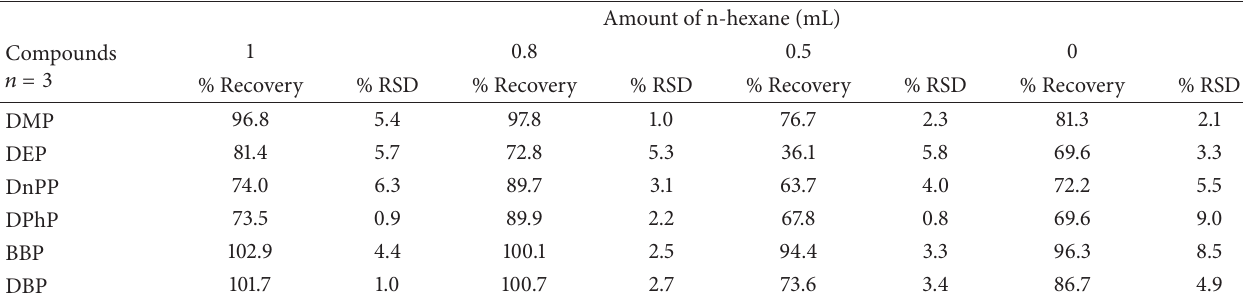
Table 2: The effect of amount of n-hexane (mL per mL of oil), on the recovery and RSD of phthalates in samples spiked with 5 mg L − 1 . Amount of n-hexane